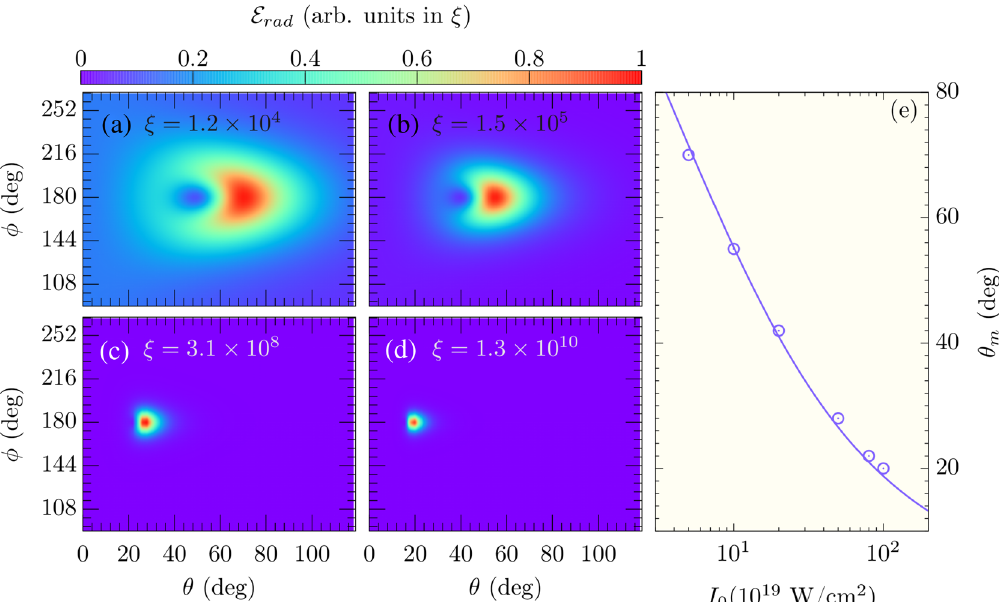
) is presented for rad